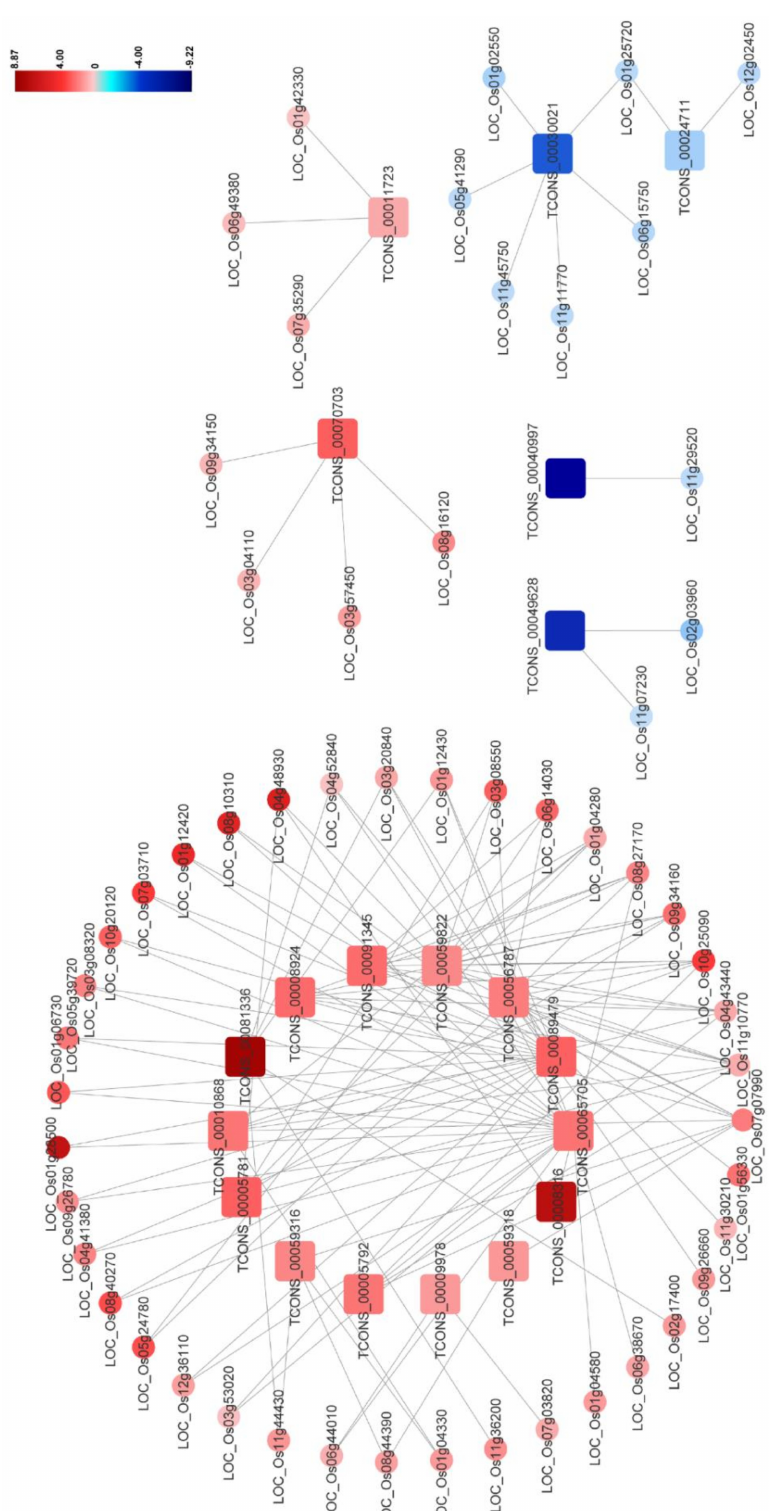
Figure 6. The network for the predicted DElncRNA–DEmRNA co-expression pairs potentially involved in plant–pathogen interaction (Pathway ID:ko004626). The square represents DElncRNA and the circle represents DEmRNA. Red indicates upregulation and blue indicates downregulation. The brighter image is the greater fold change. Each selected pair is with a person’s correlation coe ffi cient > 0.95 or < − 0.95. Identitiess of DElncRNAs and DEmRNAs are shown in the